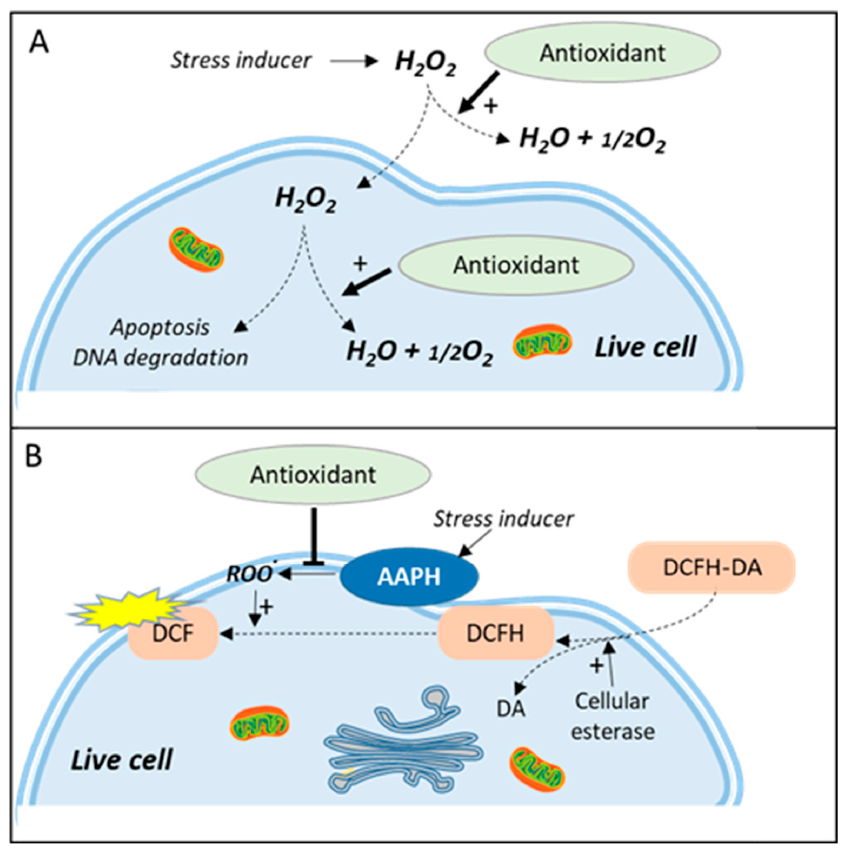
Figure 2. Live cell antioxidant assays based on chemical stress inducers. ( A ) Catalase-like assay using H 2 O 2 as the stress inducer. The antioxidant effect is measured as the ability to inhibit H 2 O 2 -induced cellular events such as apoptosis or DNA degradation. ( B ) CAA assay using AAPH as the stress inducer. DCFH-DA is trapped in the cell in the form of DCFH which can be transformed by peroxidation products into the fluorescent DCF. Antioxidant effect is measured as the ability to inhibit the formation of AAPH-induced lipid